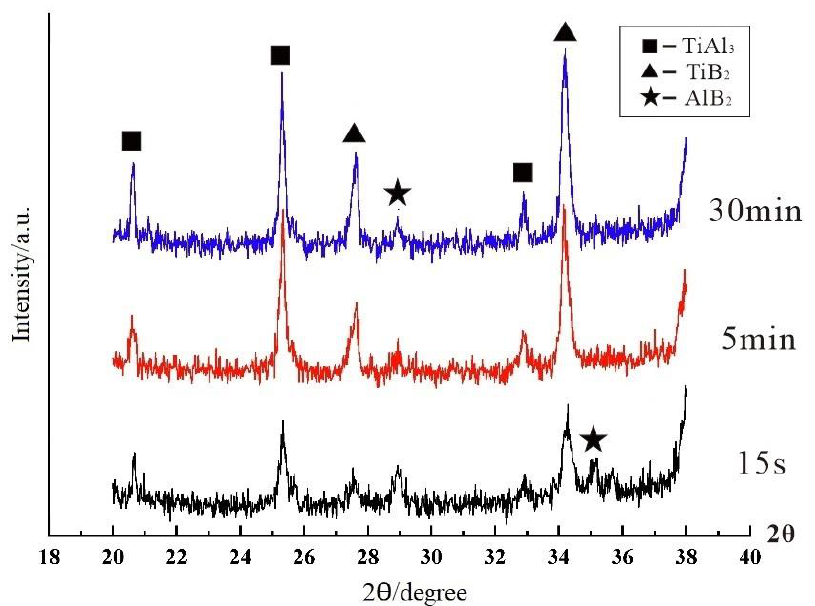
Figure 5. XRD analysis of Al – Ti – B Master Alloy prepared by Ti-sponge route at 800 °C with different reaction times.